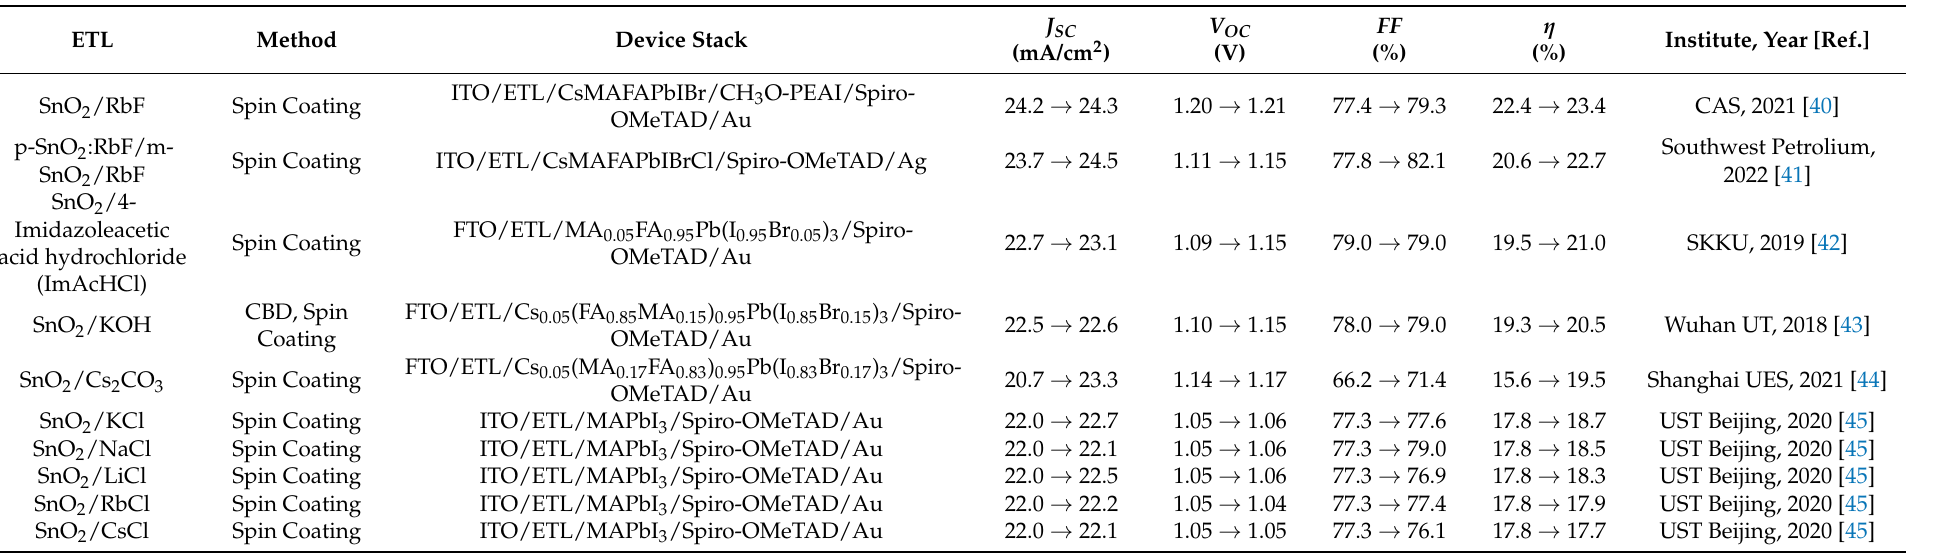
Table 3. Summary of perovskite-solar cells based on surface modification of SnO 2 ETL by ionic